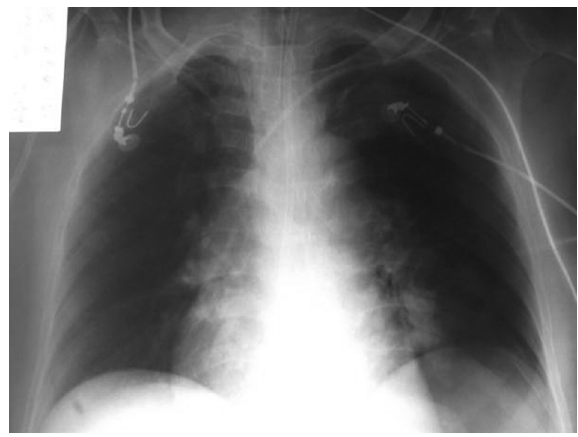
Figure 1 - Control X-ray obtained after insertion of the central venous